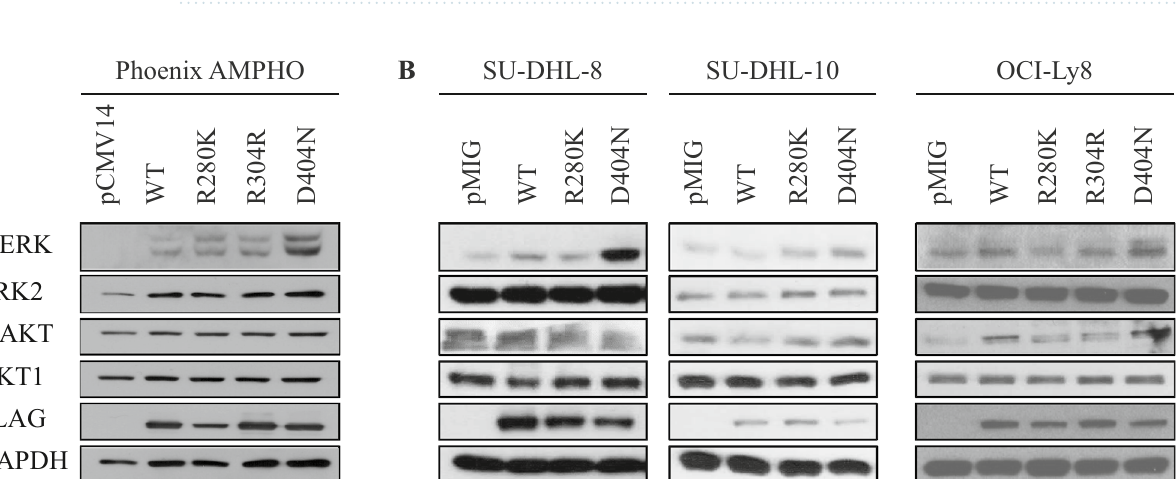
Table 2. Free energy of binding ( (cid:31) G bind ) predicted for the interaction complexes involving HRAS and the three RASGRP4 systems considered (i.e. WT, R280K and D404N). The relative increase of the binding energy observed in RASGRP4 mutants compared to the wild-type protein are quantified as (cid:31)(cid:31) G bind . All results are expressed as kcal/mol.